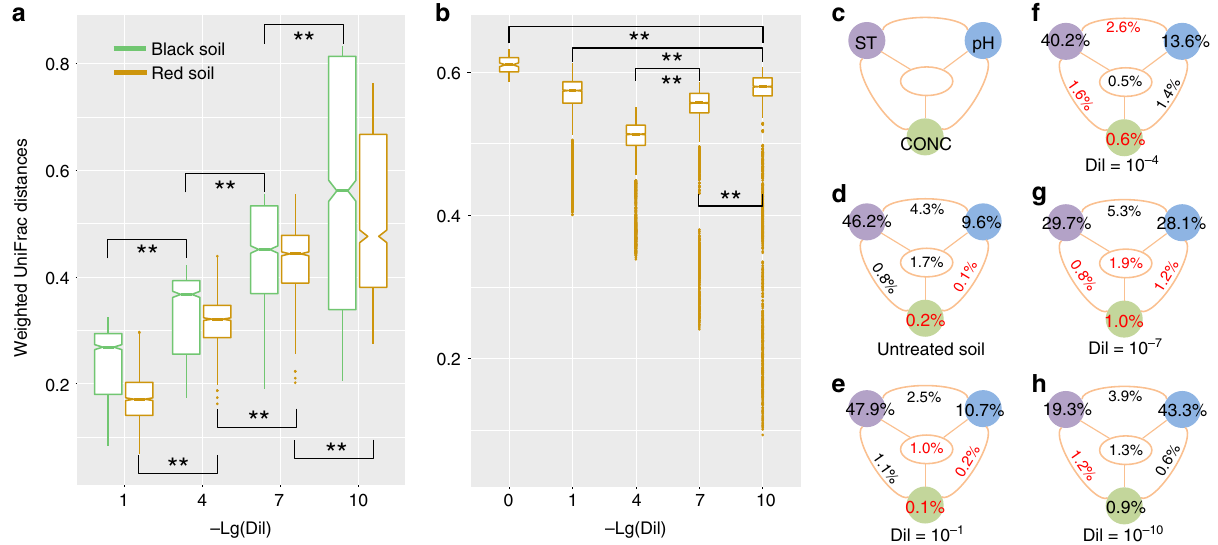
Fig. 2 Bacterial community variations between and within soil types. a Weighted Unifrac distances of pairwise bacterial communities from different pH levels within black and red soils, respectively, at each dilution level. b Weighted Unifrac distances of pairwise bacterial communities at different dilution levels between black and red soil samples. Lg(Dil) indicates the Lg-transformed dilution level. Lg(Dil) = 0 represents the untreated soil. Asterisks indicate signi fi cance: ** P -value < 0.01 based on Tukey ’ s HSD test. Boxplot: median, 25%/75% percentiles, and the highest, lowest, and extremely values are shown. c Variation partitioning analysis (VPA) among soil type (ST), soil pH (pH), and the concentrations of Ca and Fe (CONC) for d untreated soil, and e 10 − 1 , f 10 − 4 , g 10 − 7 , and h 10 − 10 diluted samples. Numbers indicate the percentage of variations in the bacterial community. Black numbers indicate signi fi cant variances ( P -value < 0.01 based on Mantel test). Red numbers indicate variances that are not signi fi cant